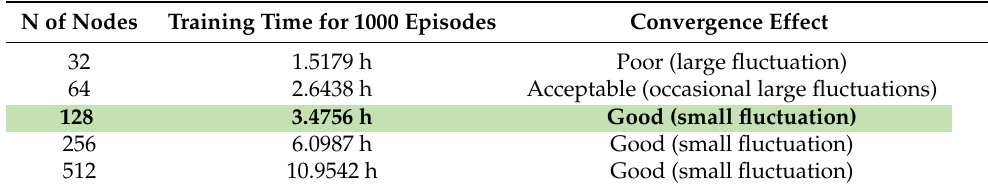
Table 1. Training effect for different numbers of nodes. N of